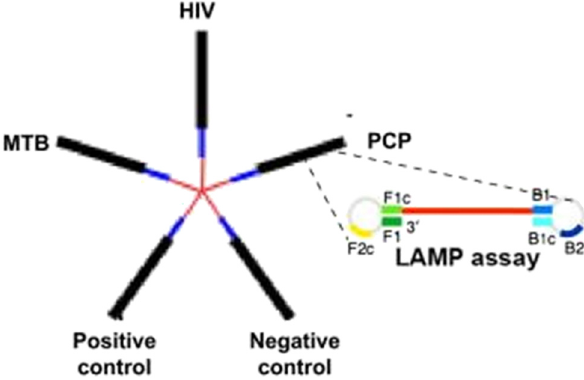
Figure 8: Schematic representation of the fi ve - channel µLAMP - based micro fl uidic device. The ampli fi cation pools in the channels are fi lled with the sample and the LAMP reaction bu ff er, then sealed. Positive samples form a white magnesium pyrophosphate precipi - tate that can be assessed with the naked eye or using agarose gel electrophoresis. Image reproduced with permission from Talanta [ 62 ]